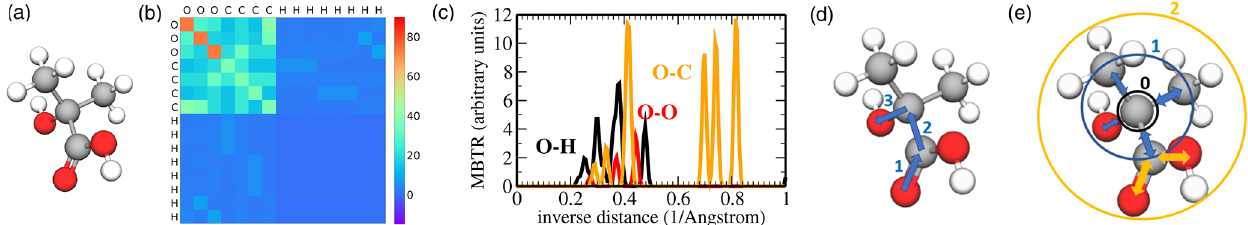
Figure 4. Pictorial overview of descriptors used in this work: (a) ball-and-stick model of 2-hydroxy-2-methylpropanoic acid, (b) corre- sponding Coulomb matrix (CM), (c) the O–H, O–O, and O–C inverse distance entries of the many-body tensor representation (MBTR), (d) topological fingerprint (TopFP) depiction of a path with length 3, and (e) Morgan circular fingerprint with radius 0 (black), radius 1 (blue), and radius 2